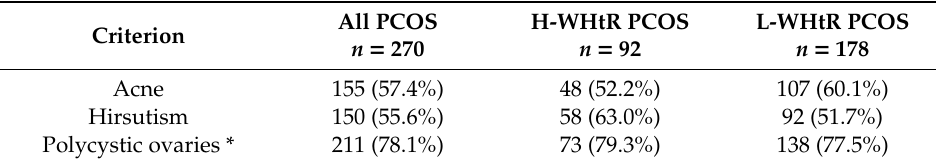
Table 4. Clinical characteristics of studied PCOS